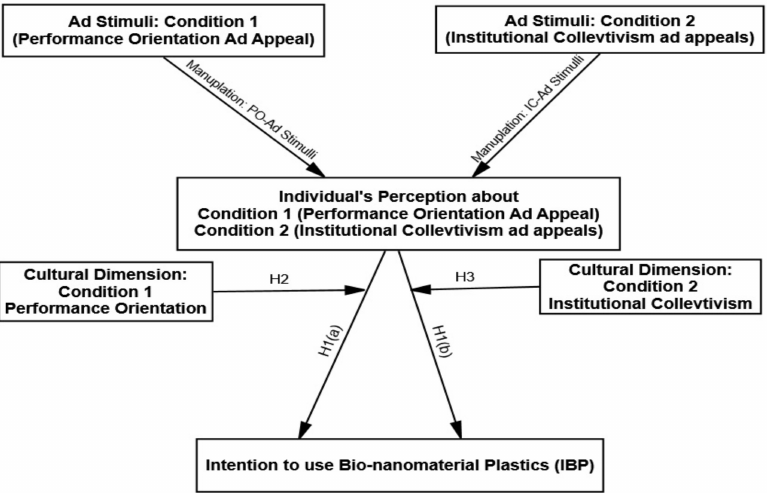
Figure 1. Proposed Conceptual